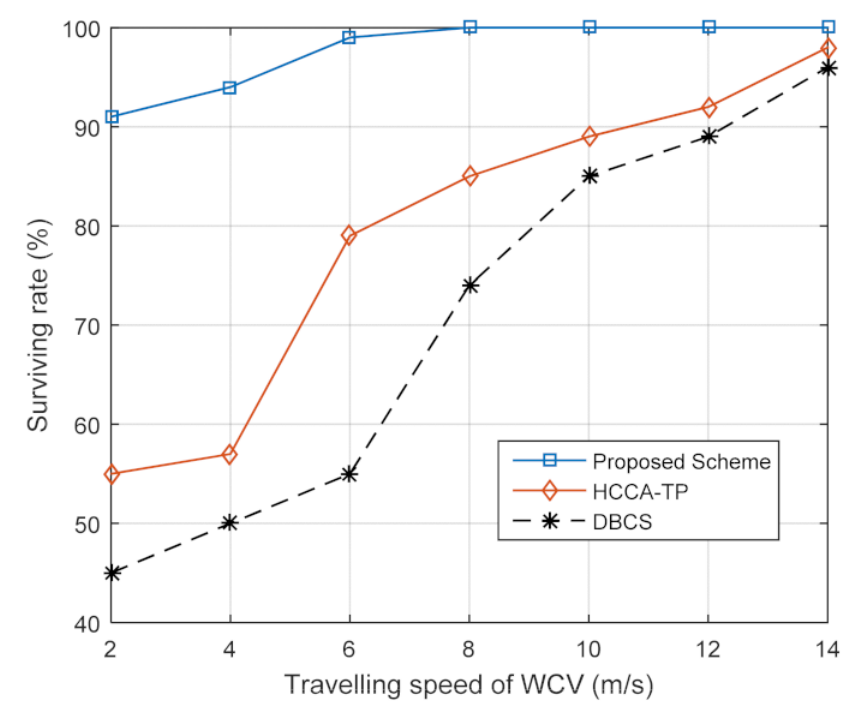
Figure 5. The surviving rate at different travelling speeds of